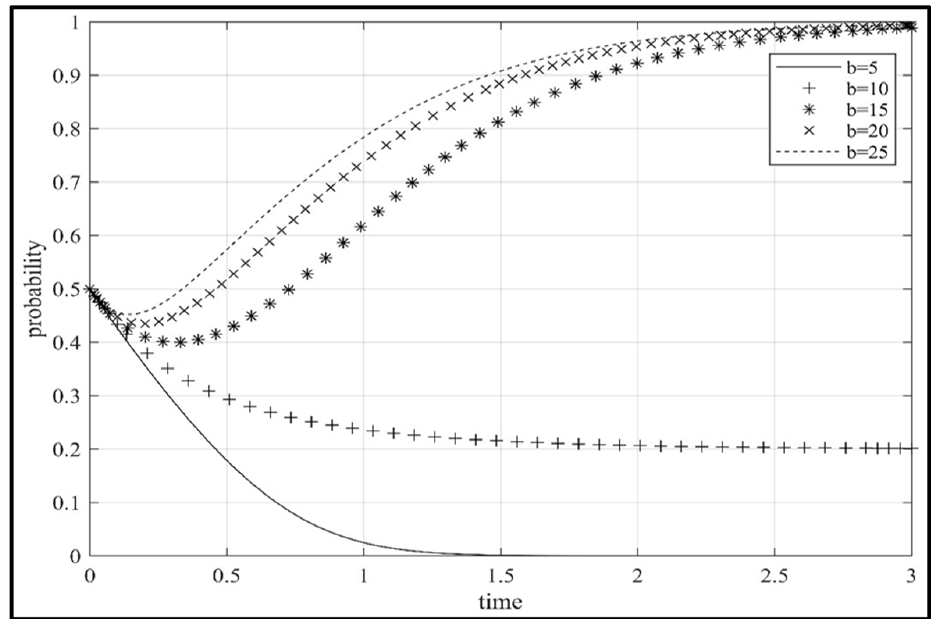
Figure 6. Evolution path of polar cold at different times with a given parameter value.